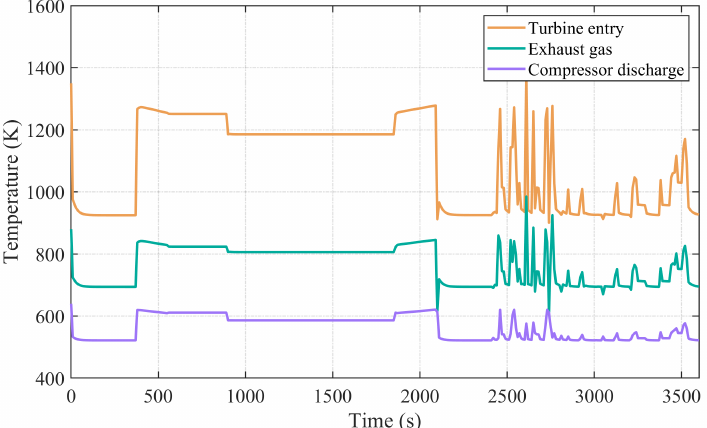
Figure 17. Temperature profile of turbine entry, exhaust gas, and compressor discharge in the turboshaft